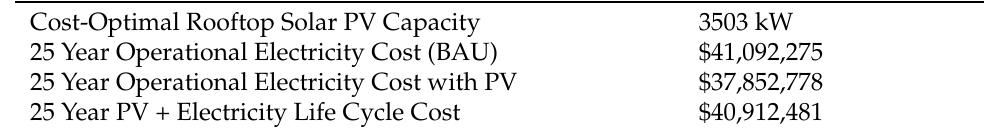
Table 2. Life cycle cost analysis of rooftop PV utilizing URBANopt REopt Gem.